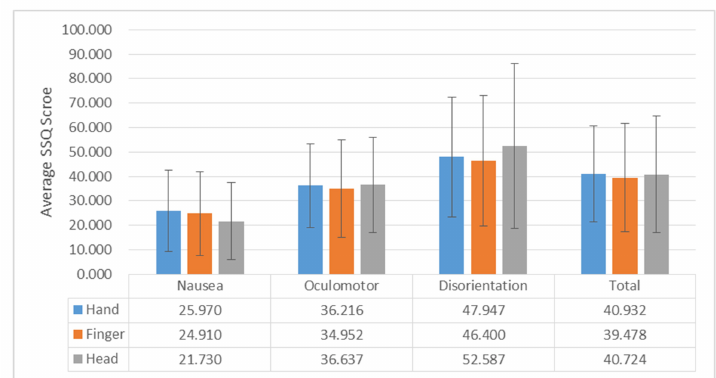
Figure 9. Average of the total simulator sickness questionnaire (SSQ) score and three scores for nausea, oculomotor symptoms, and disorientation for each interaction ( +/ - standard deviation of the